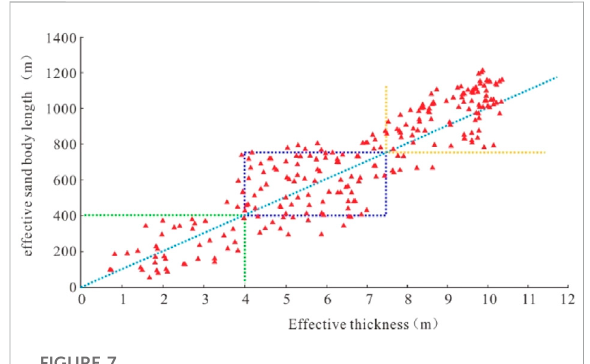
FIGURE 7 Intersection diagram of effective thickness versus effective sand body length.